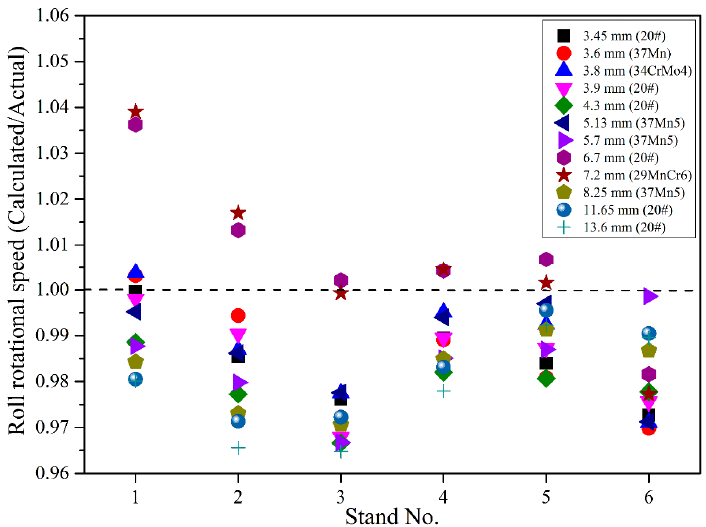
Figure 11. Comparison of the calculated and the actual roll rotational speed in field operation.